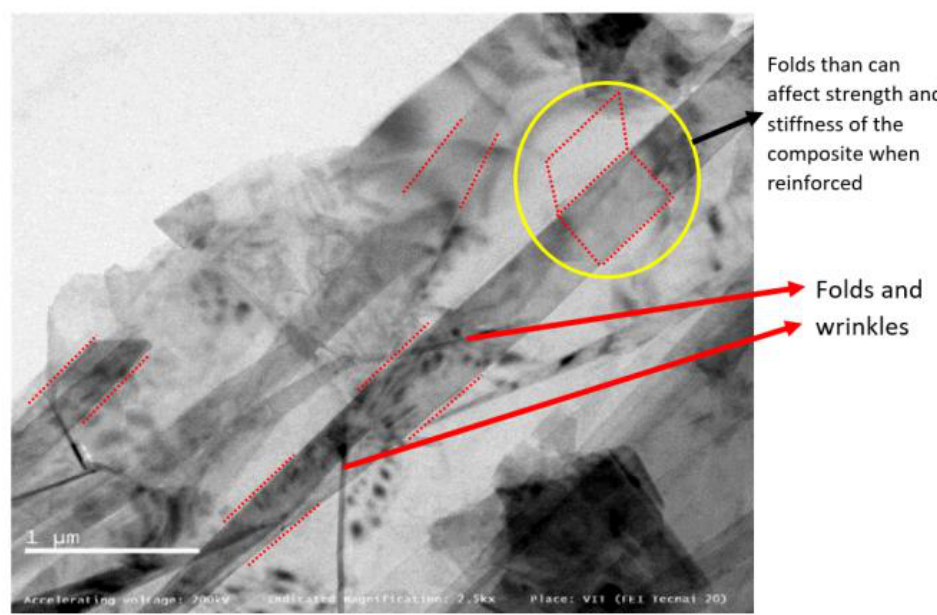
Figure 3. HR-TEM observation of graphene at 2500×.